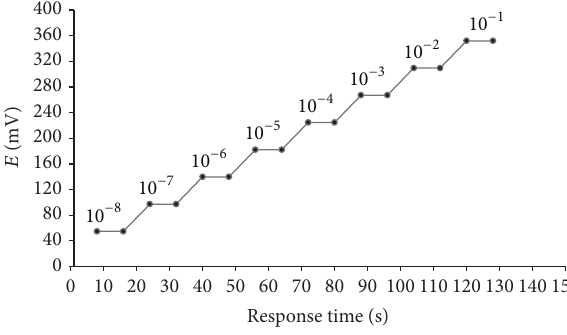
Figure 2: Variation of potential with time for CPE8. Table 2: Change in slope and detection limit with time for